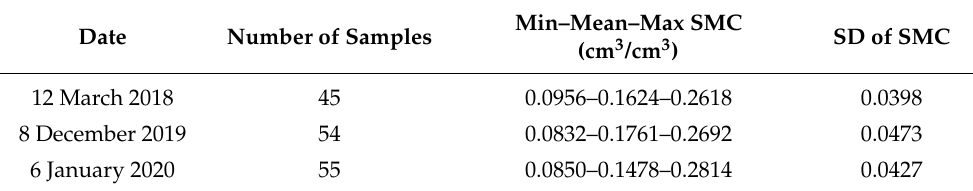
Table 1. Collected soil moisture content (SMC) data in the study areas.